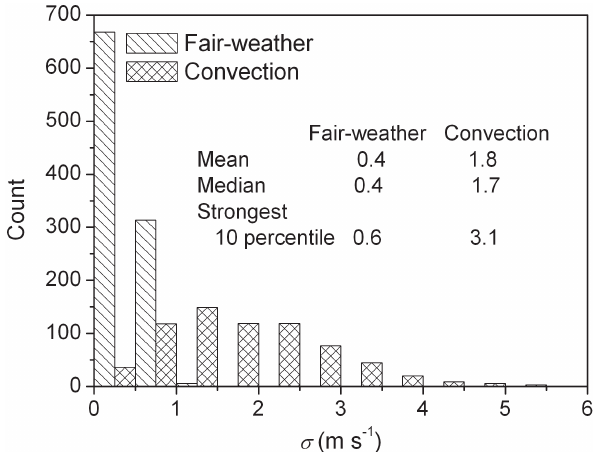
Fig. 7. Distribution of spectral width in up- and down-draft cores in the tropopause region